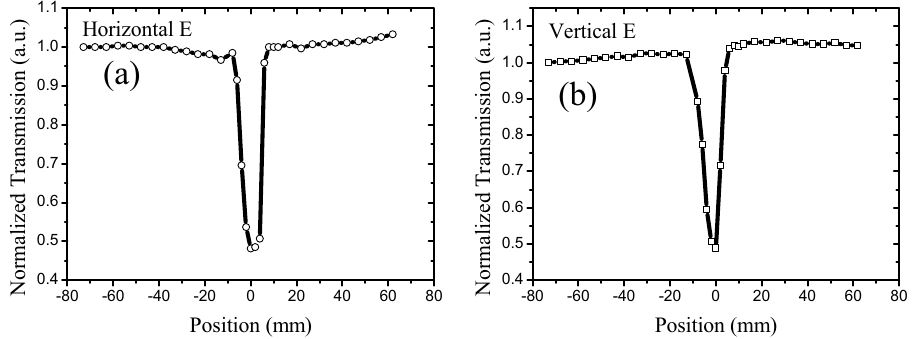
Figure 6. Z-scan results of carbon particles in DI water. 527-nm laser with 50 mW power; transmission of carbon particles suspension was 15%; cuvette was 10 mm